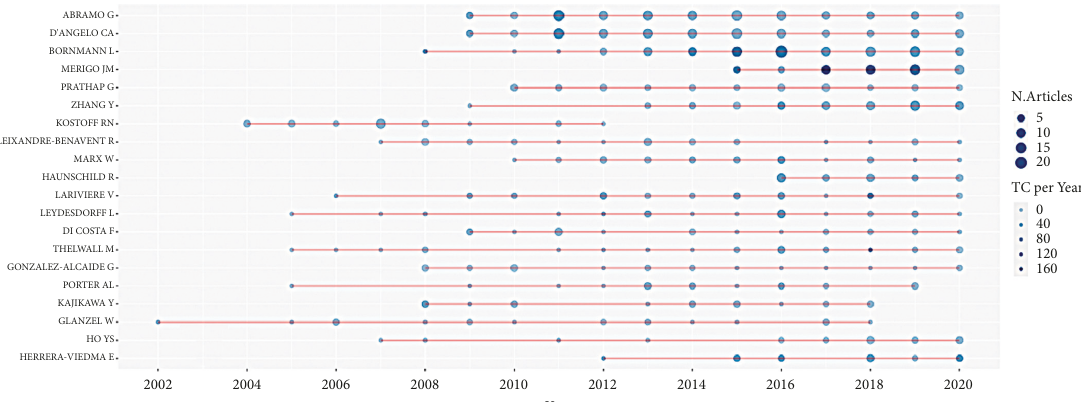
Figure 6: Annual number of publications by lead authors.